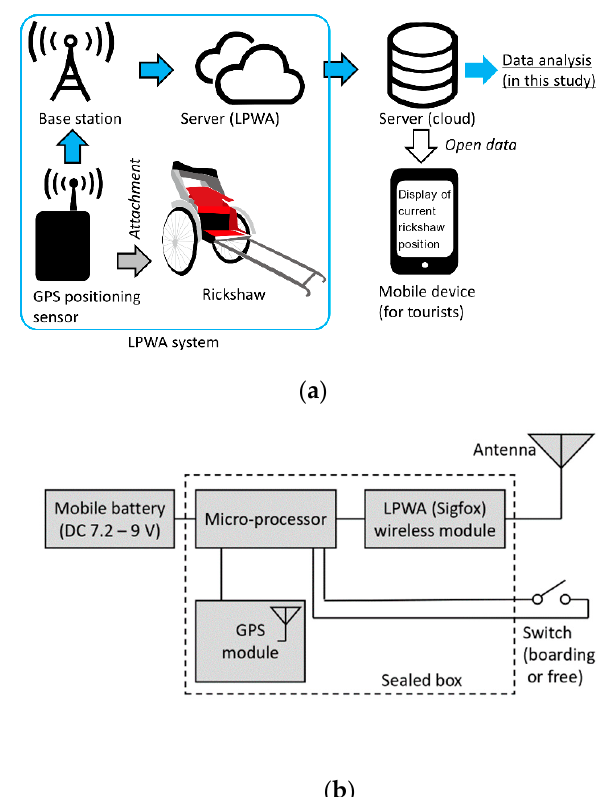
Figure 1. System and device designed for detecting and accumulating rickshaw spatiotemporal data. ( a ) System with signal flows from rickshaw to tourists. Current rickshaw position is open data from internet. ( b ) Configuration of GPS positioning sensor with electronic modules.